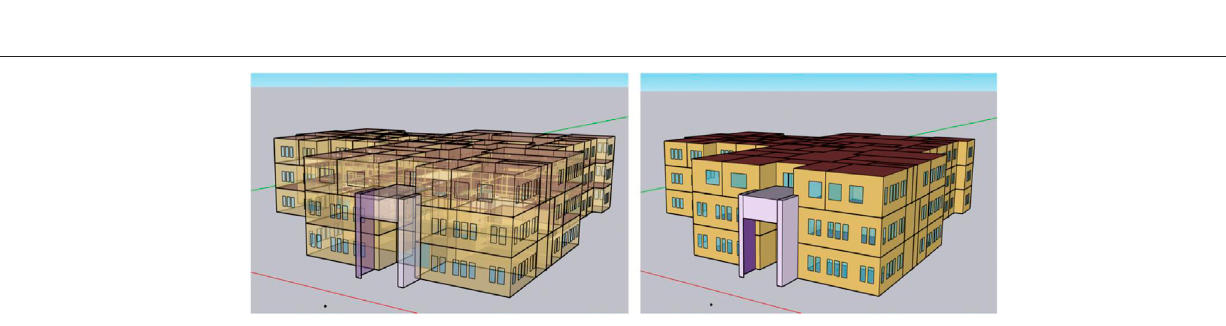
FIGURE 1 | The framework that was implemented to assess human – building interactions and building electricity consumption under different case scenarios.